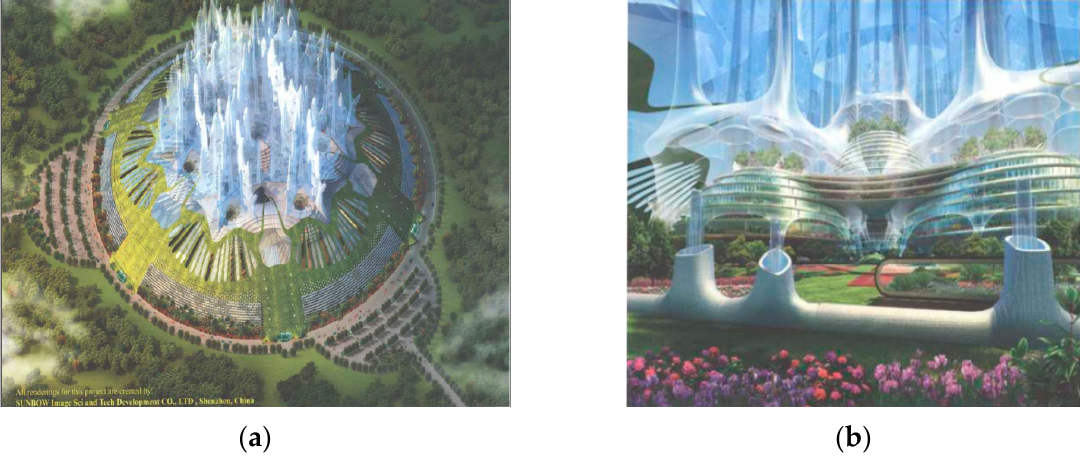
Figure 8. ( a , b ) Global Health Centre in Guangzhou.